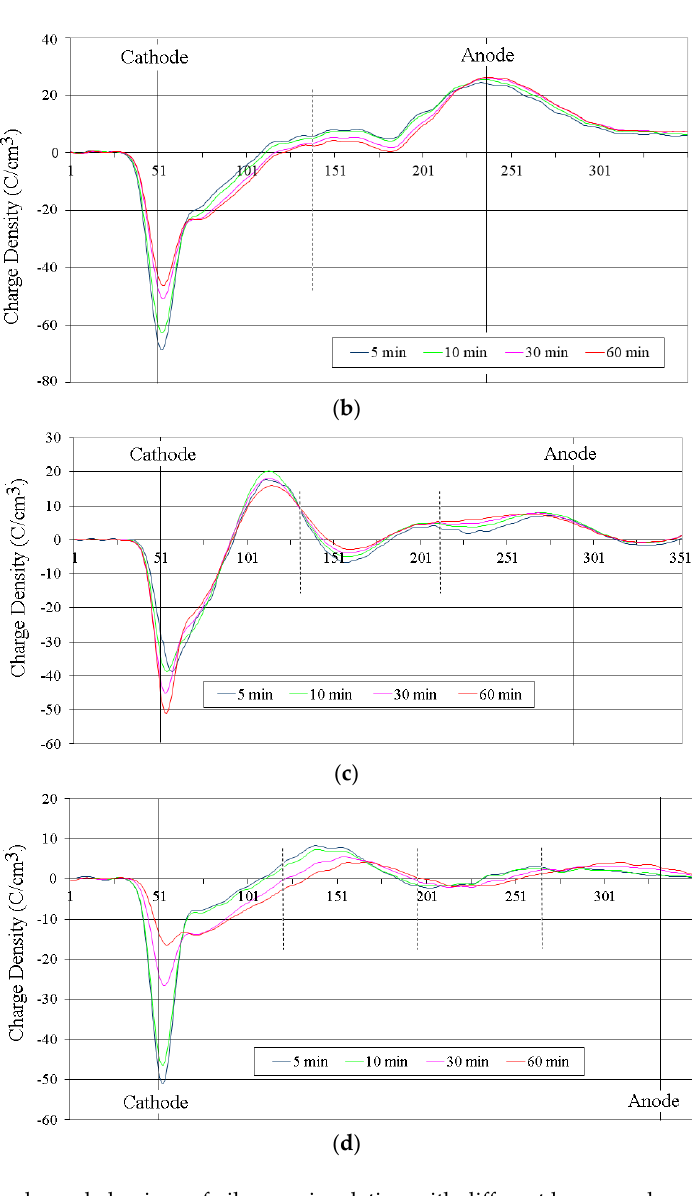
Figure 15. Space charge behaviour of oil ‐ paper insulation with different layers under volt ‐ on condition (( a ) one layer, ( b ) two layers; ( c ) three layers; ( d ) four layers).